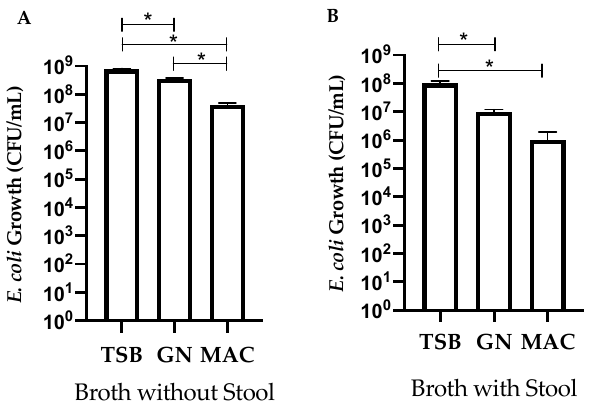
Figure 1. Effect of the tryptic soy broth (TSB), Gram-negative (GN), and MacConkey (MAC) broths for E. coli (STEC) enrichment in the absence (( A ), n = 52 isolates) or presence (( B ), n = 25 isolates) of stool. Bars represent the CFU/mL calculated from serial dilutions on blood agar plates ( A ) or CHROMagar TM ( B ). Error bars represent the standard error of the mean. * Indicates growth is significant; ANOVA p ≤ 0.05.